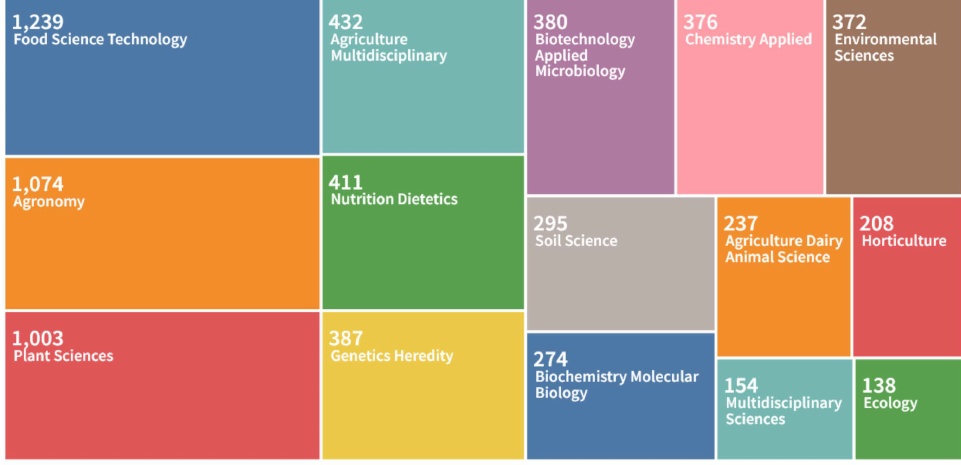
Figure 1. Tree-map chart showing the number of articles that focused on rye and rye products in different Web of Science scientific categories (chart presents the data obtained from Web of Science Core Collection base for 15 categories from 2010 to 11 December